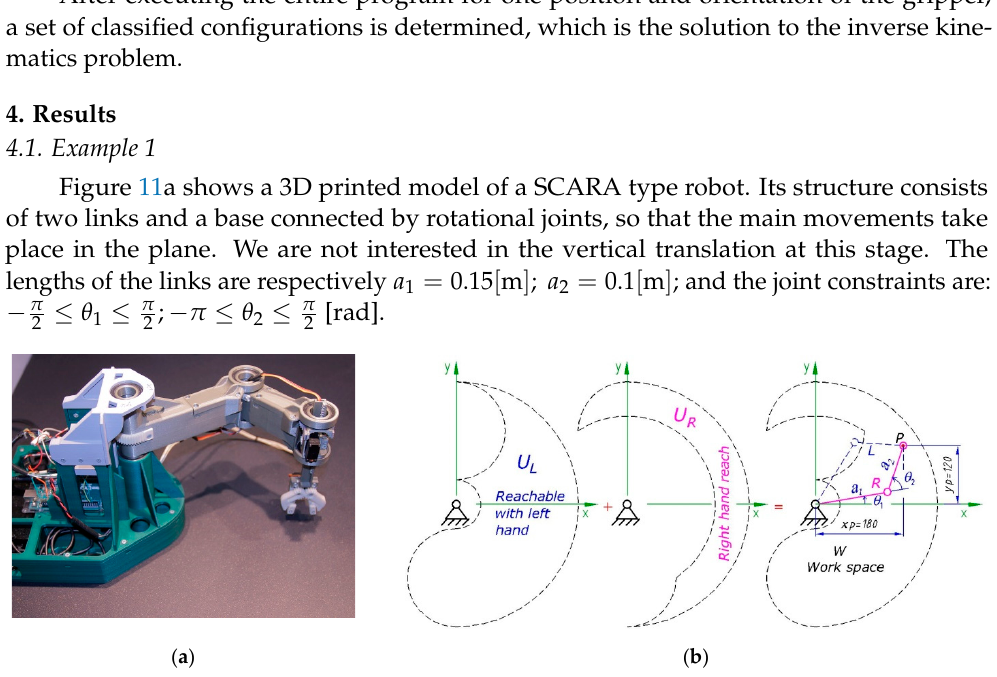
Figure 11. ( a ) 3D printed model of a SCARA type robot; ( b ) Reachability area with left- and right-hand configuration and workspace. Figure 11b shows the left 𝑈 (cid:3013) and right 𝑈 (cid:3019) hand reachability zones for this robot. The union of these two areas represents the robot’s workspace: 𝑤 = 𝑈 (cid:3013) ∪ 𝑈 (cid:3019) (14) Section f represents a region where both left-handed and right-handed solutions can exist.